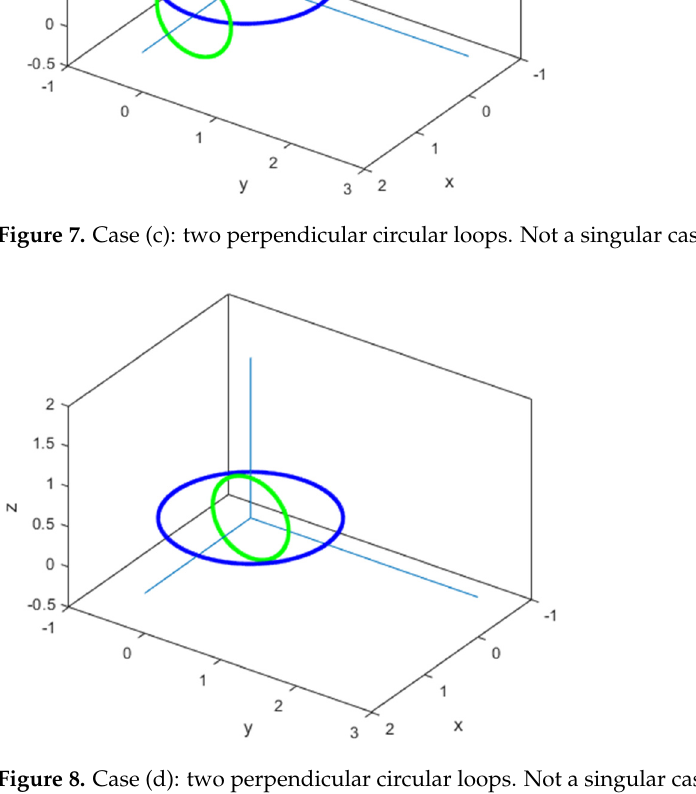
Figure 8. Case (d): two perpendicular circular loops. Not a singular case, ( a = 1, b = c = 0, L = l = 1).